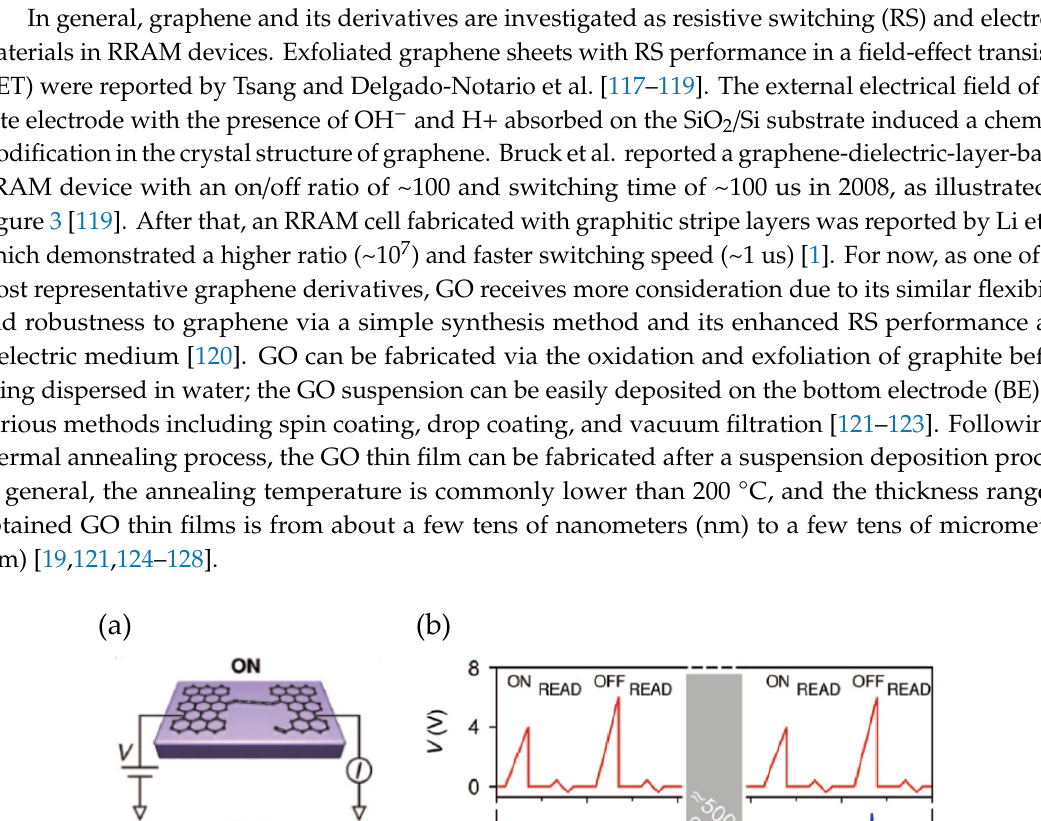
Figure 2. Unipolar ( a ) and bipolar ( b ) resistive switching (RS) behavior of RRAM device [3,107–111] .